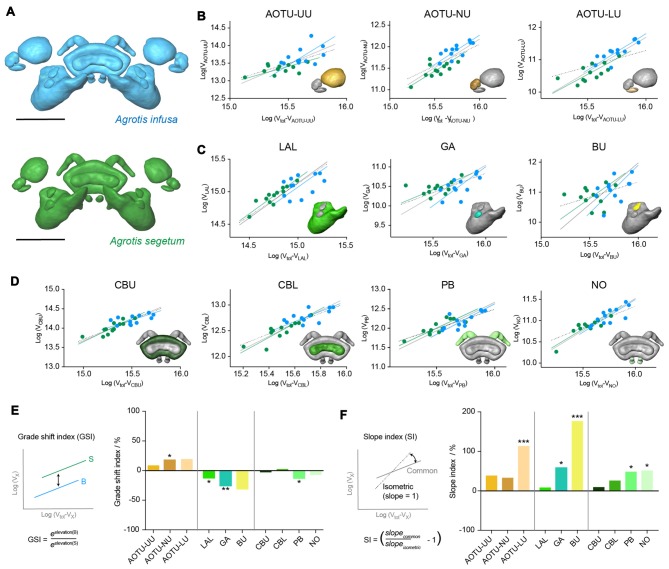
Results from standardized major axis regression analysis comparing the Bogong moth and the Turnip moth compass neuropils. (A) Surface rendering of neuropils in each species. (B–D) Regression analysis data; colors matching neuropil color in (A). For each neuropil individual data-points are shown together with the individual regression line of each species, the best-fit common regression line (gray) and the isometric expectation (dotted). The inset depicts the respective neuropil for each graph highlighted in color. (B) Neuropils of the AOTU. (C) Neuropils of the LX. (D) Neuropils of the CX. (E) Analysis of grade shift indices (GSI) of all neuropils. Positive values indicate a shift towards bigger volumes in the Bogong moth, while negative values indicate smaller volumes in the Bogong moth. Left: schematic illustration and formula of how the GSI is calculated. Asterisks indicate significance level of GSI. (F) Analysis of slope index (SI) for all neuropils. Values larger than zero indicate steeper than isometric scaling. Asterisks illustrate significant deviations from isometric scaling. Left: schematic illustration and formula of how the SI is calculated. Scale bars: 200 μm. Abbreviations: AOTU, anterior optic tubercle; UU, upper unit; LU, lower unit; NU, nodular unit; CBL, lower division of the central body; CBU, upper division of the central body; BU, bulb; LAL, lateral accessory lobe; GA, gall; PB protocerebral bridge; NO, noduli.